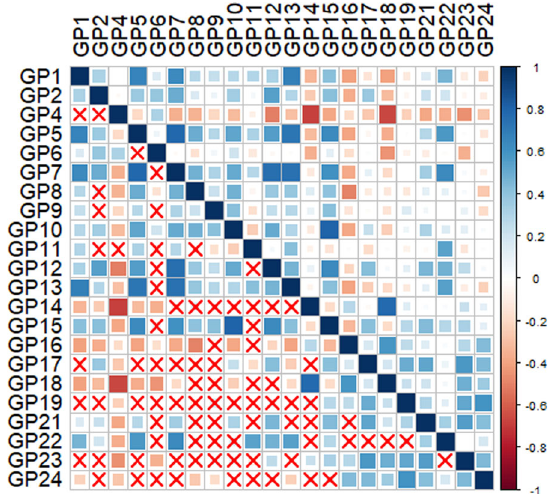
Fig. 3 The correlation coef fi cients in independent glycans. Statistically signi fi cant associations between two glycans were shown, p < 0.05, while the insigni fi cant correlation coef fi cients were shown using symbol ( “ × ” ) in the boxes. The positive correlations are represented by blue color, while negative correlations are repre- sented by red